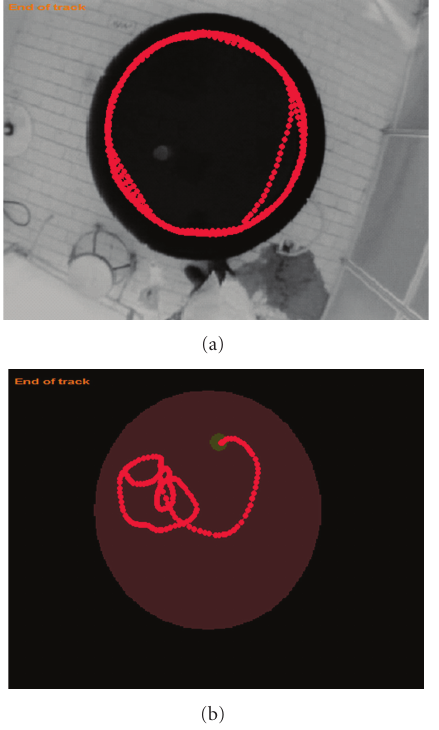
Figure 7: Example of computer tracking from probe trial (90s duration). (a): “aged-impaired + PBS”; (b): “aged-impaired + MSCs”. The rat of “aged-impaired” swims in a concentric